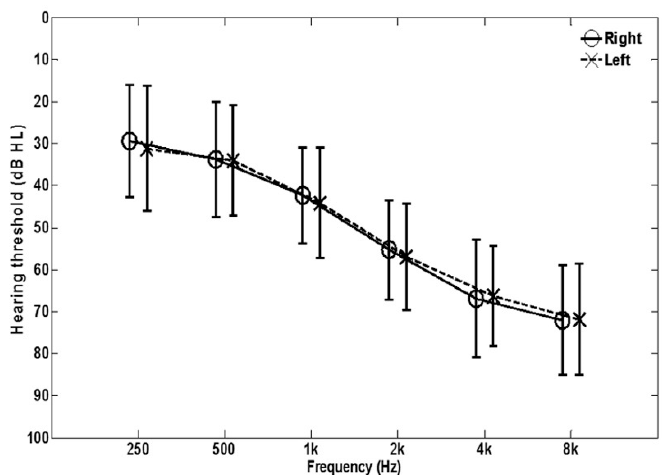
Figure 1. Mean audiogram for the 34 participants. Error bars show ± 1 SD.